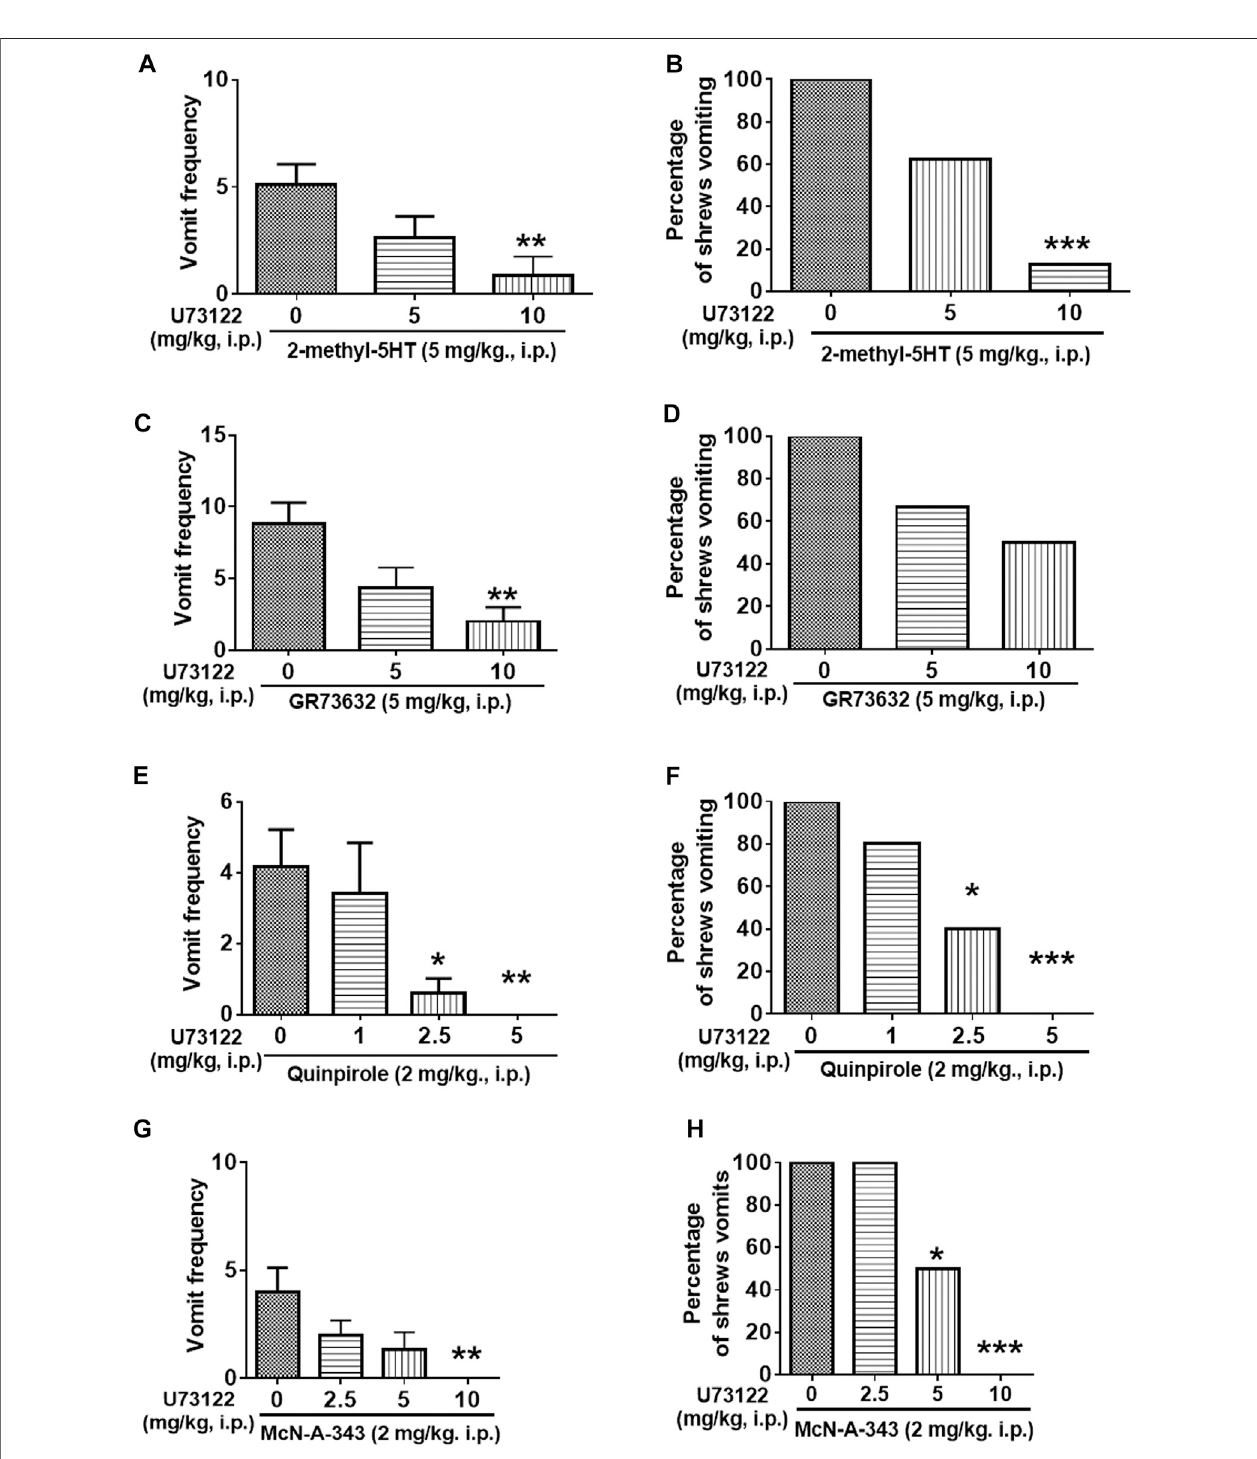
FIGURE 8 | The antiemetic effects of the PLC inhibitor U73122 against vomiting evoked by diverse receptor-selective emetogens. Varying doses of U73122 (i.p.) were injected to different groups of shrews 30 min prior to an injection of a fully effective emetic dose of selective serotonin 5-HT 3 receptor agonist 2-Methyl-5-HT (5 mg/kg,i.p., n (cid:1) 8) (A,B) ,theselectiveneurokininNK 1 receptoragonistGR73632(5 mg/kg,i.p., n (cid:1) 6) (C,D) ,thedopamineD 2/3 receptorpreferringagonistquinpirole (2 mg/kg, i. p., n (cid:1) 5) (E,F) , or the muscarinic M 1 receptor agonist McN-A-343 (2 mg/kg, i. p., n (cid:1) 6) (G,H) . Emetic parameters were recorded for the next 30 min (A,C,E,G) The frequency of emesis was analyzed with Kruskal-Wallis non-parametric one-way ANOVA followed by Dunnett ’ s post hoc test and presented as mean ± SEM. (B,D,F,H) Thepercentageofshrewsvomitingwasanalyzedwithchi-squaretestandpresentedasthemean.* p < 0.05,** p < 0.01,*** p < 0.001,**** p < 0.0001vs. 0 mg/kg (controls pretreated with vehicle of